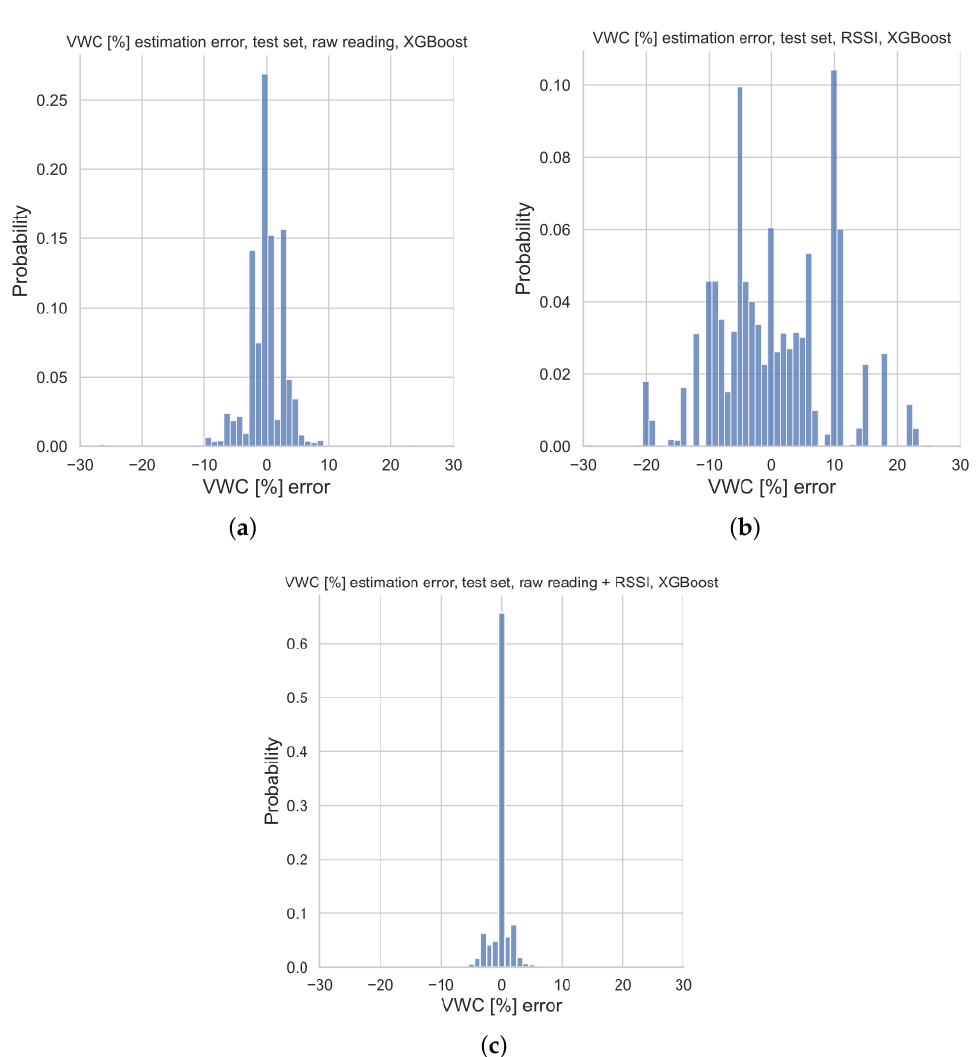
Figure 9. Histograms of the estimation errors of the predicted VWC values for the three model versions on the test set: ( a ) calibrated real sensor relying only on raw readings, ( b ) virtual sensor taking as input RSSIs and ( c ) augmented sensor grounded on both raw readings and